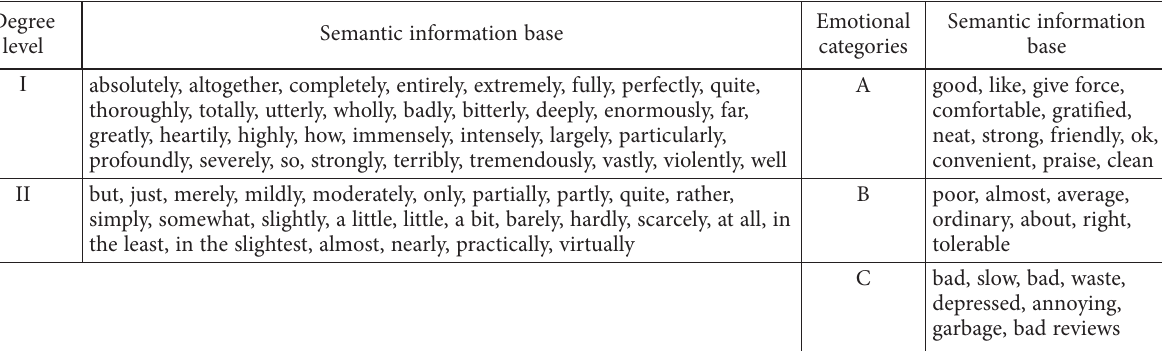
Table 3. Semantic information base of online reviews on public property service quality Degree level